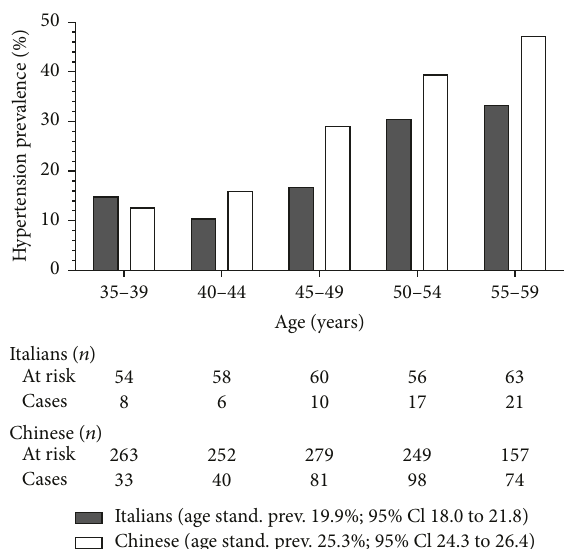
Figure 2: Prevalence of hypertension, diabetes, hypercholesterole- mia (total cholesterol ≥ 240 mg/dL), and hypertriglyceridemia (tri- glycerides ≥ 200mg/dL) in the Chinese and Italian